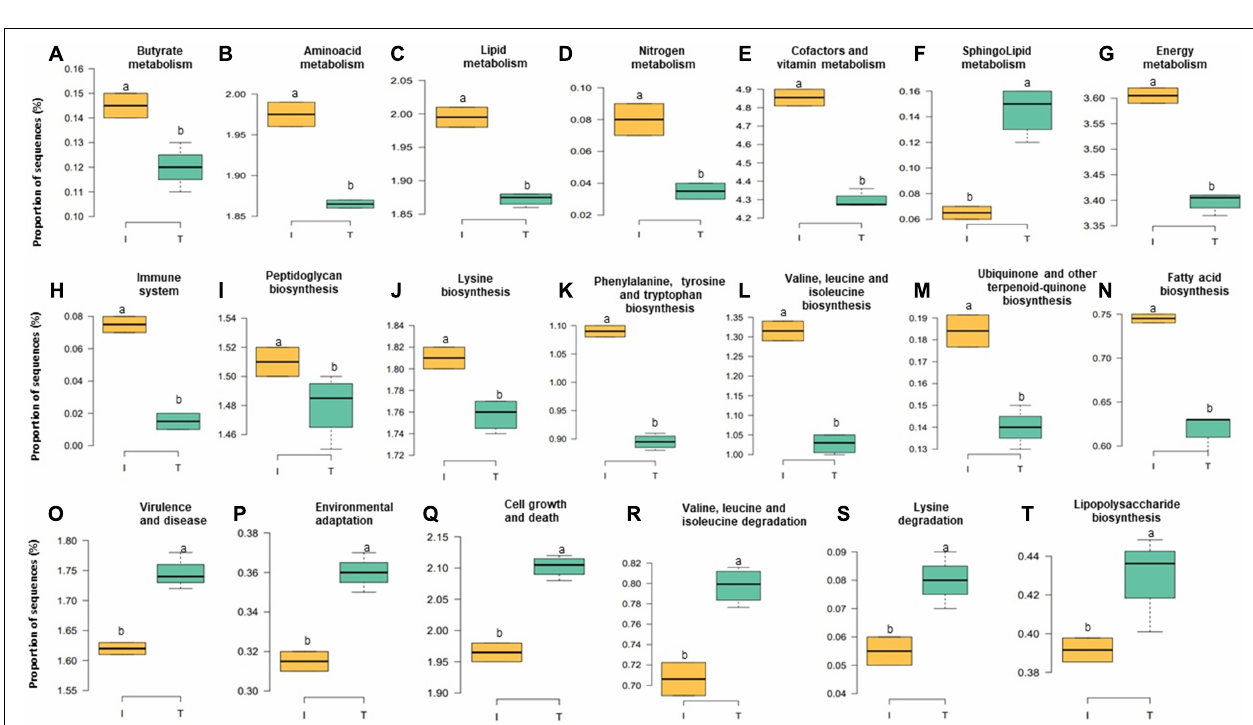
FIGURE 6 | Relative abundance at microbial genesin the fecal microbiota of I (semi-intensive) and T (traditional) beef production systems (A–T) . Different letters (a,b) are significantly different, P- value < 0.005.